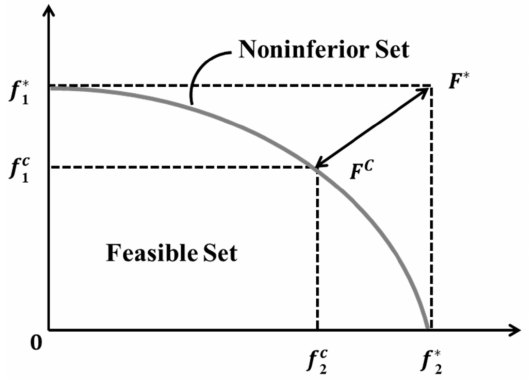
Figure 4. The compromise solution of the VIKOR